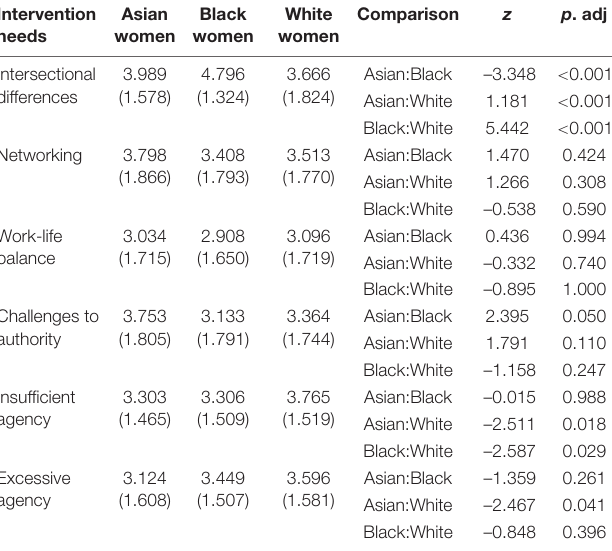
TABLE 4 | Mean rankings, standard deviations (in parentheses), and Dunn tests’ contrasts of each intervention need per racialized group. Intervention